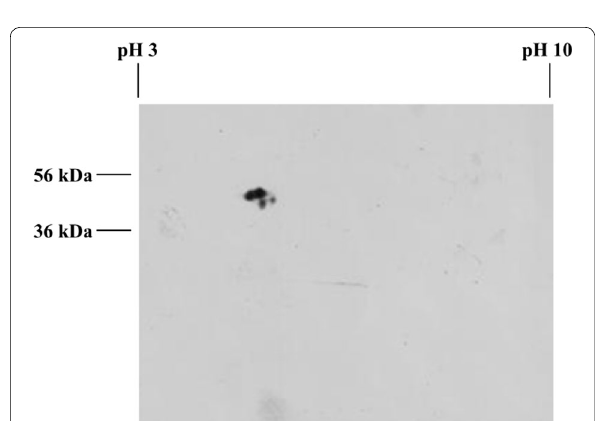
Fig. 5 Western blot of two-dimensional electrophoresis of affinity chromatography purified recombinant APA protein. The electrofocusing was performed on a linear IPG (pH 3.0 to 10.0). The pH gradient is indicated on the top of the figure and the molecular size marker on the